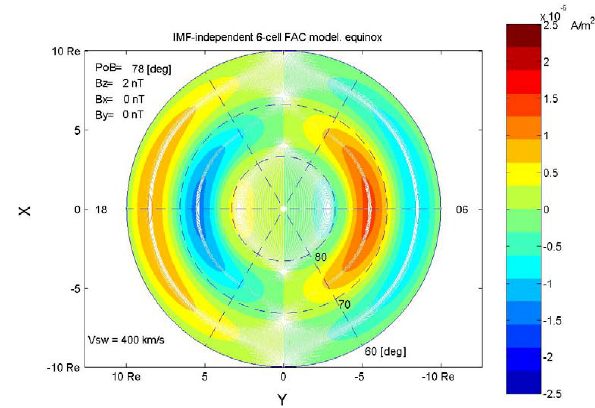
Fig. 2. This figure depicts a six-cell, large-scale FAC system (a ground state) under equinox conditions where the IMF perpendicu- lar components, B x and B y , are taken to be equal to zero. The polar cap boundary (PoB) is taken at 78 ◦ magnetic degrees and corre- sponds to an IMF equal to 2nT. Note that this six-cell FAC system can also exist under zero IMF B z conditions. The FAC intensity is evaluated at ionospheric heights (given in polar coordinate sys- tem), taking into account the magnetic flux conservation principle. The source region is assumed at a radial distance r equal to 10 Re (shown by X0Y coordinates). Red color and positive FAC intensity values correspond to inward FAC flowing toward the ionosphere, blue color and negative FAC values – to outward FAC flowing away from the ionosphere. The FAC intensity distribution possesses a maximum around 1 µ A/m 2